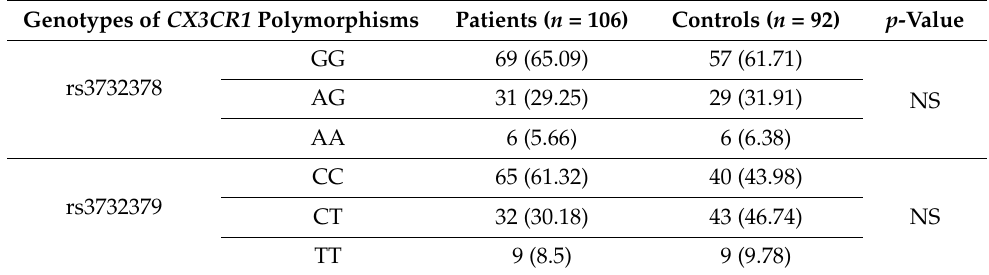
Table 2. Genotype distribution of the rs3732378 and rs3732379 polymorphims of the CX3CR1 gene in patients with end-stage renal disease (cases) and controls.